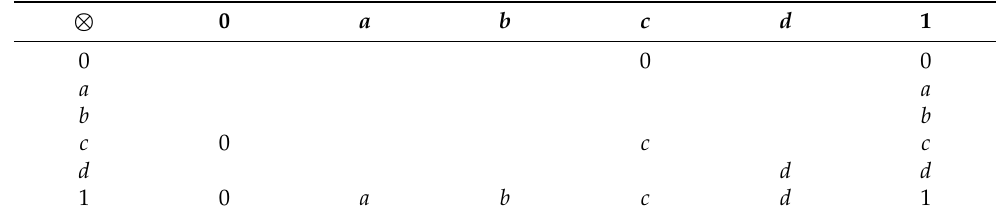
Figure 2. Hasse diagram of lattice L . Table 3. The operation ⊗ .